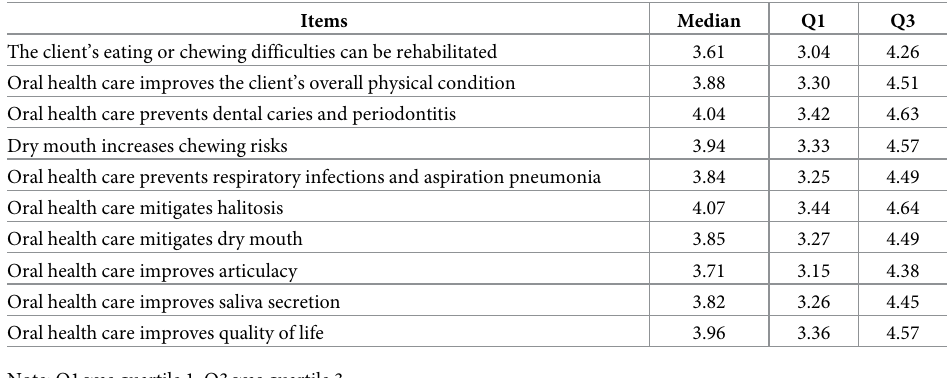
Table 4. The oral health care knowledge scale.